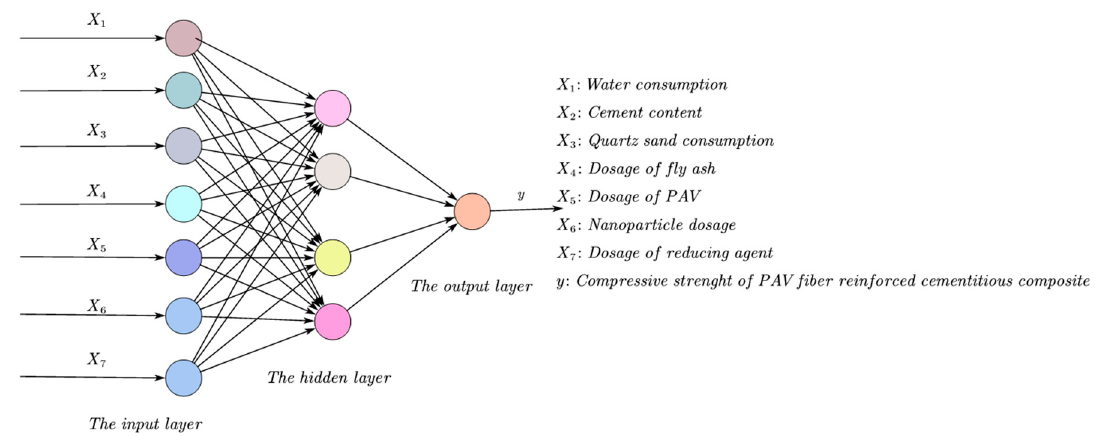
Figure 3. Architecture of three-layer backpropagation (BP) neural network model.